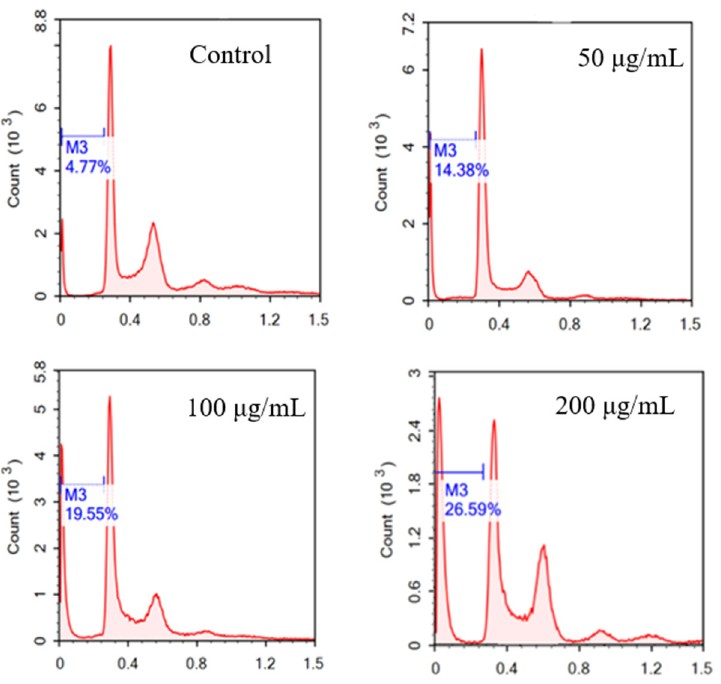
Figure 6. The effect of RLE on the cell cycle distribution of HT-29 cells by flow cytometry.